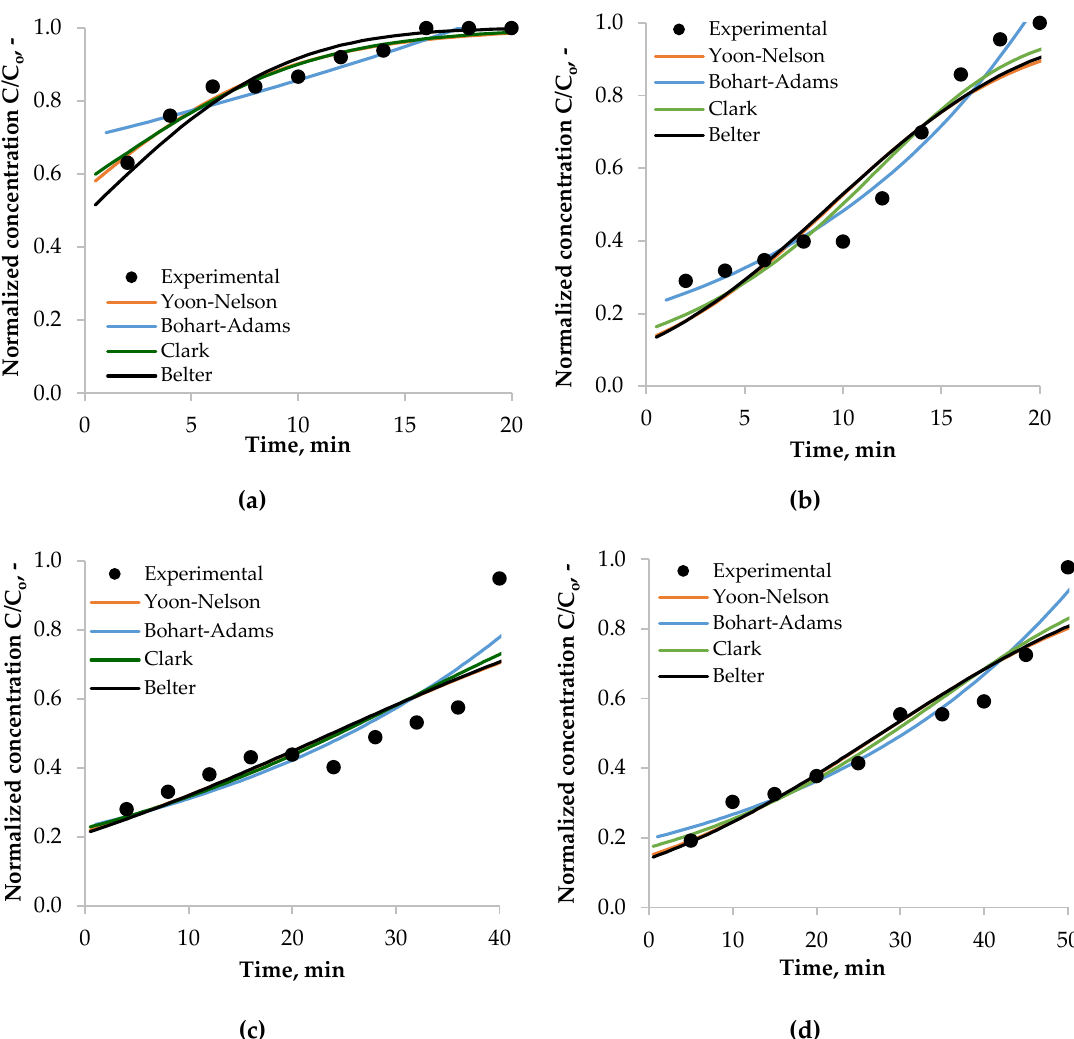
Figure 7. ( a ) Predicted breakthrough curves of BTX adsorption onto raw sawdust at flow rate of 50 mL / min; ( b – d ) experimental and calculated breakthrough curves for modified sawdust at flow rate of 50, 25, and 10 mL / min, respectively.